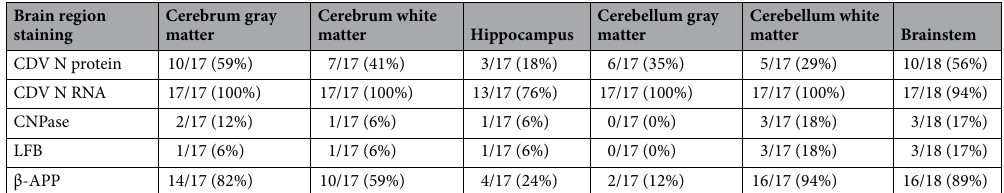
Table 2. Numbers of animals, which showed positive staining for the indicated markers in the different brain areas. N: nucleoprotein, CNPase: 2,3 ′ -cyclic–nucleotide 3 ′ -phosphodiesterase, LFB: luxol fast blue, β-APP: beta-amyloid precursor